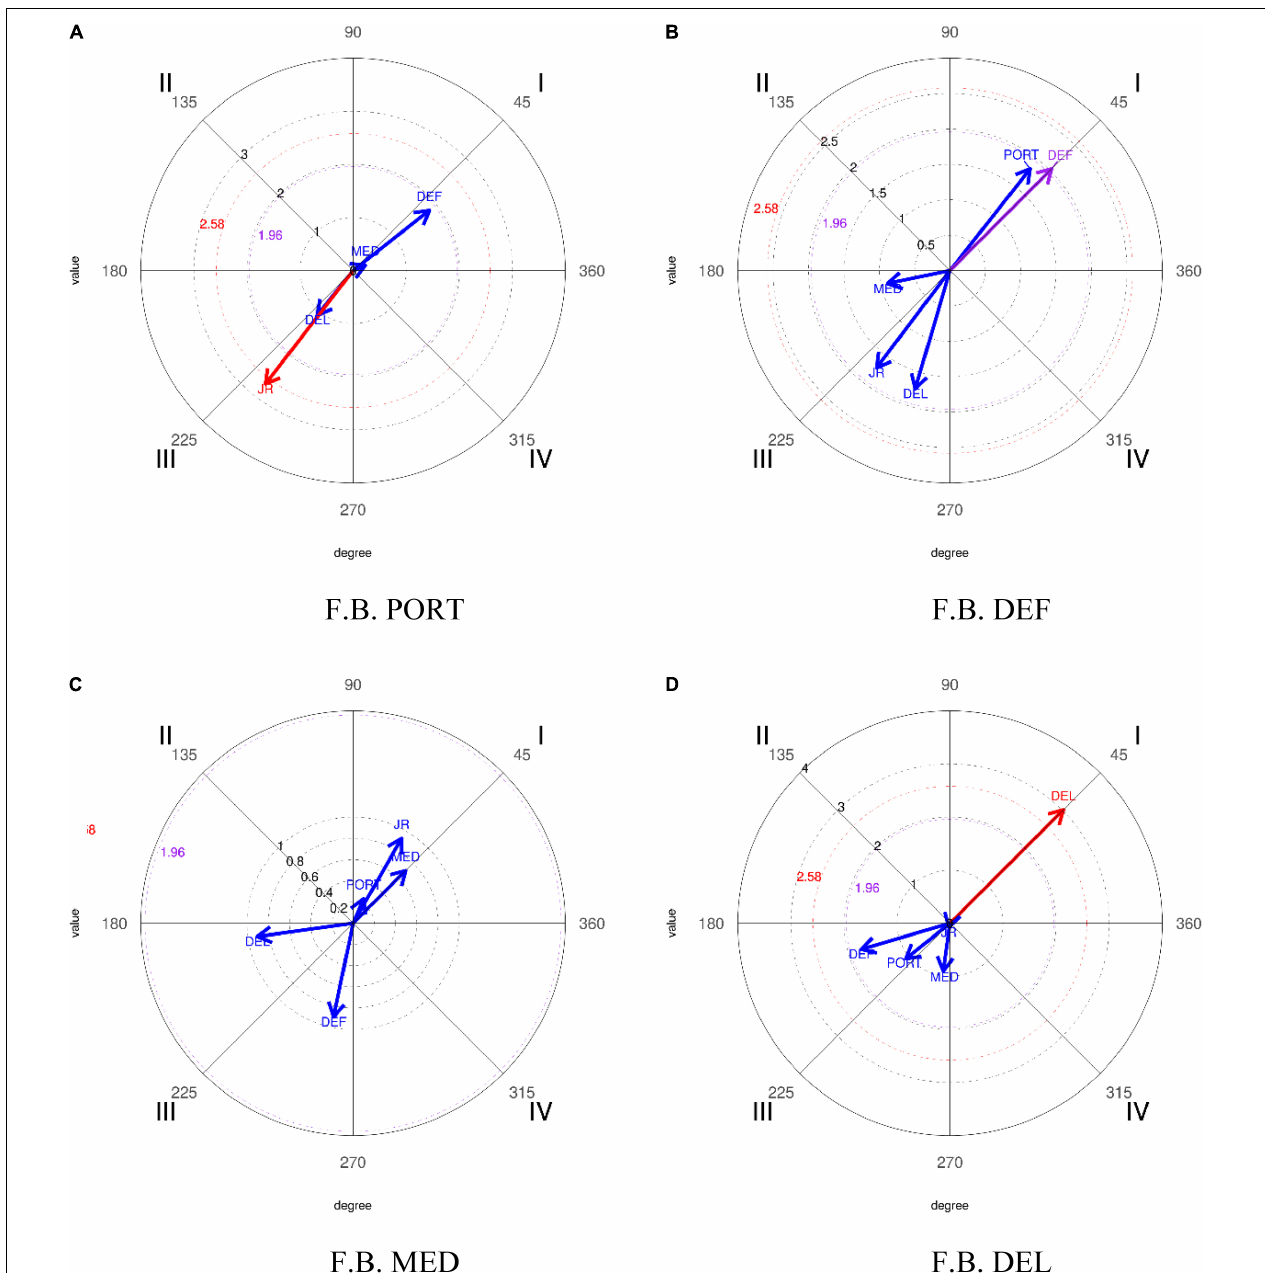
FIGURE 5 | Representation of the behavioral maps establishing the different categories as focal behavior, in relation to the lines that structure the team for the 2018–2019 season. *FB, focal